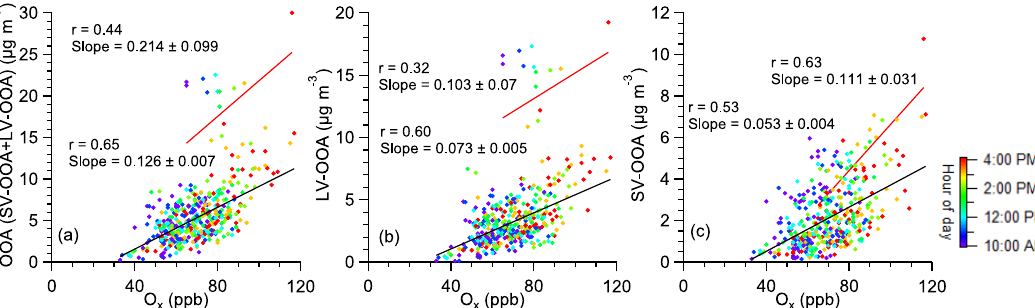
Figure 9. Scatter plots of (a) OOA; (b) LV-OOA; and (c) SV-OOA vs. O x during daytime (10:00–16:00) in spring 2015. Note that the